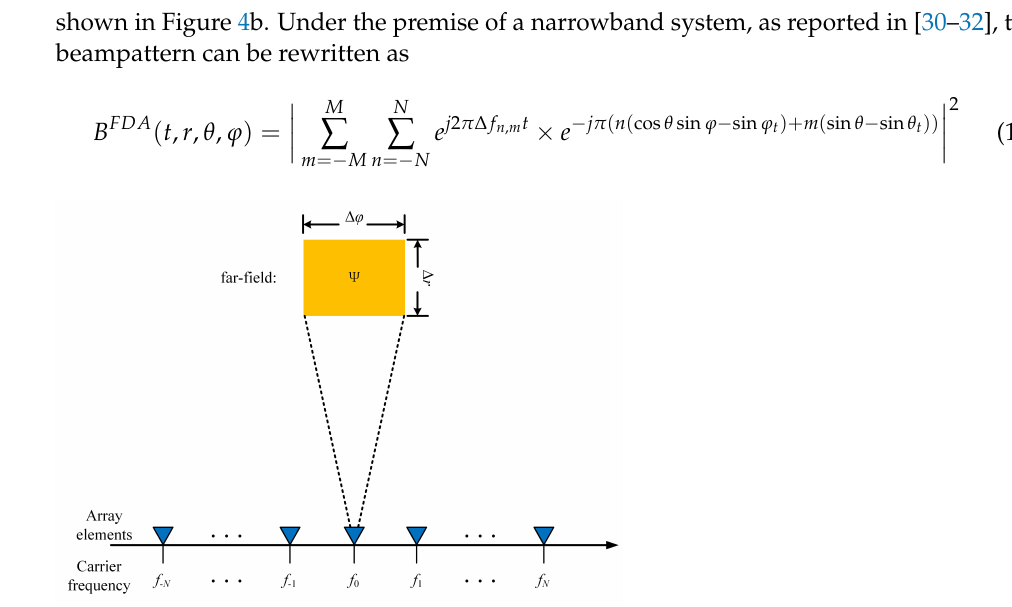
Figure 3. Sketch of the WPT configuration designed in [30].